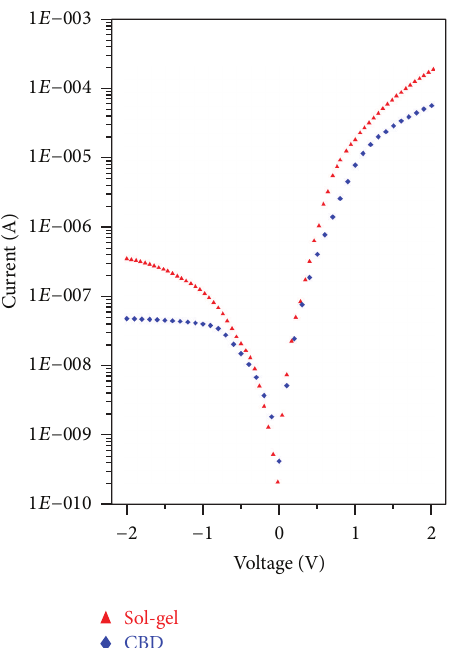
Figure3: 𝐼 - 𝑉 characteristicsoftheAu/CuO/p-Si/AlMISstructures. of the straight line region of the forward bias ln 𝐼 - 𝑉 charac-